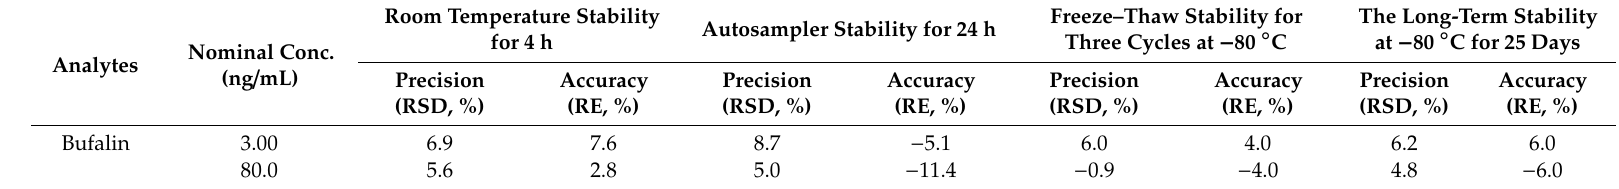
Table 5. Stability of bufalin in rat plasma under various storage conditions ( n =